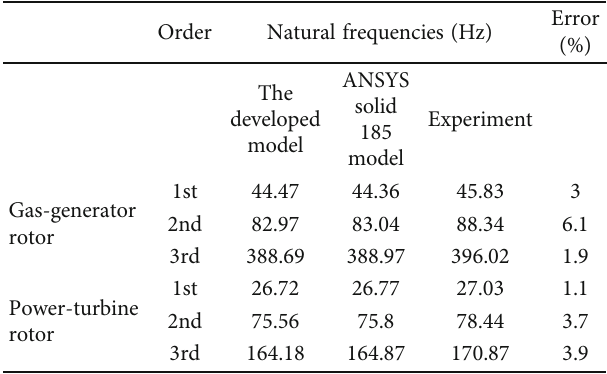
Table 5: Natural frequency comparison ( ω = 0